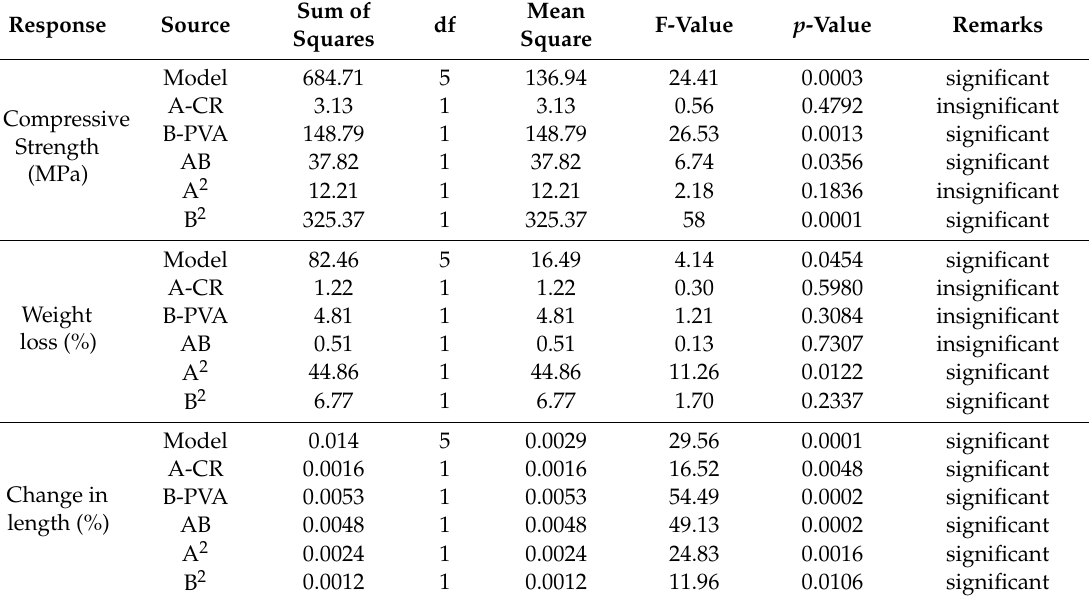
Table 4. Summary of variance